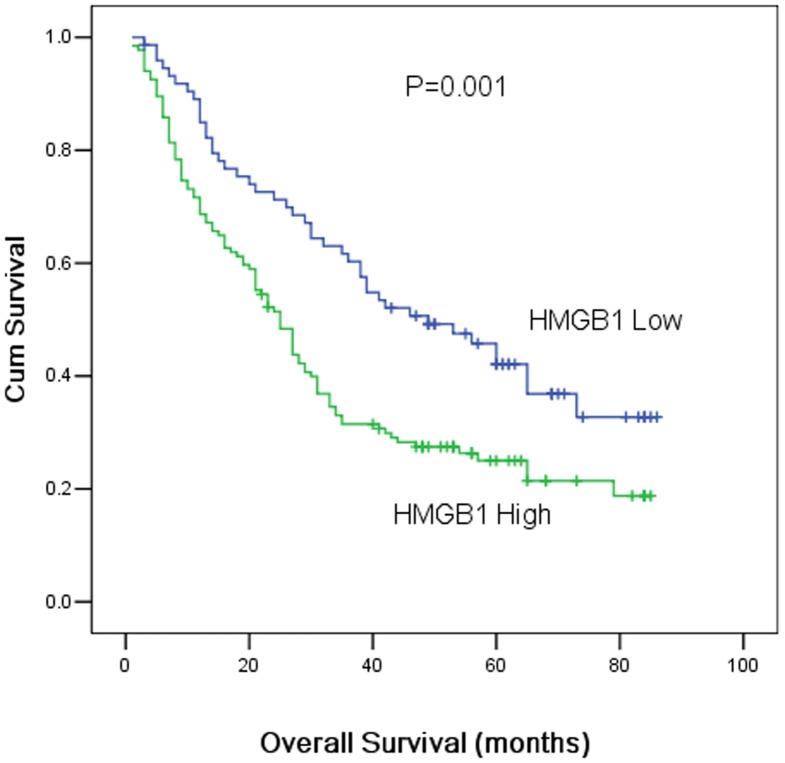
Kaplan-Meier survival analysis of primary HCC patients (n = 208) after surgical resection with high HMGB1 expression (n = 134) and low HMGB1 expression (n = 74).The survival rate for patients in the HMGB1-high group was significantly lower than that for patients in the HMGB1-low group (log-rank, p = 0.001).